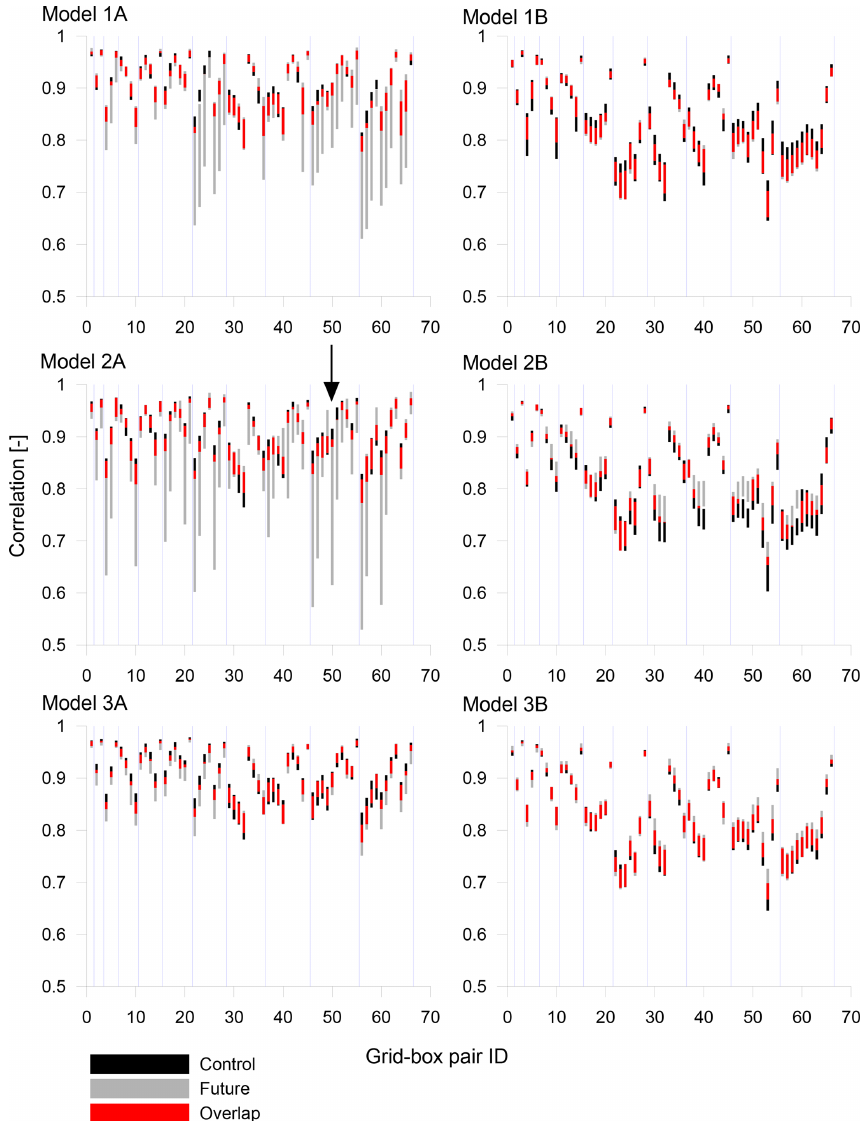
Figure 4. The 95% confidence intervals of the individual cross-correlation coefficients for overlapping wet periods for all models. The identifiers of grid-box pairs (ID) are explained in Fig. 2. The blue lines separate identifiers located in successive rows in the correlation matrix (see Fig. 2). The arrow marks the confidence intervals around the r 5 , 11 (ID 50) of the model 2A, discussed in more detail in Sect.